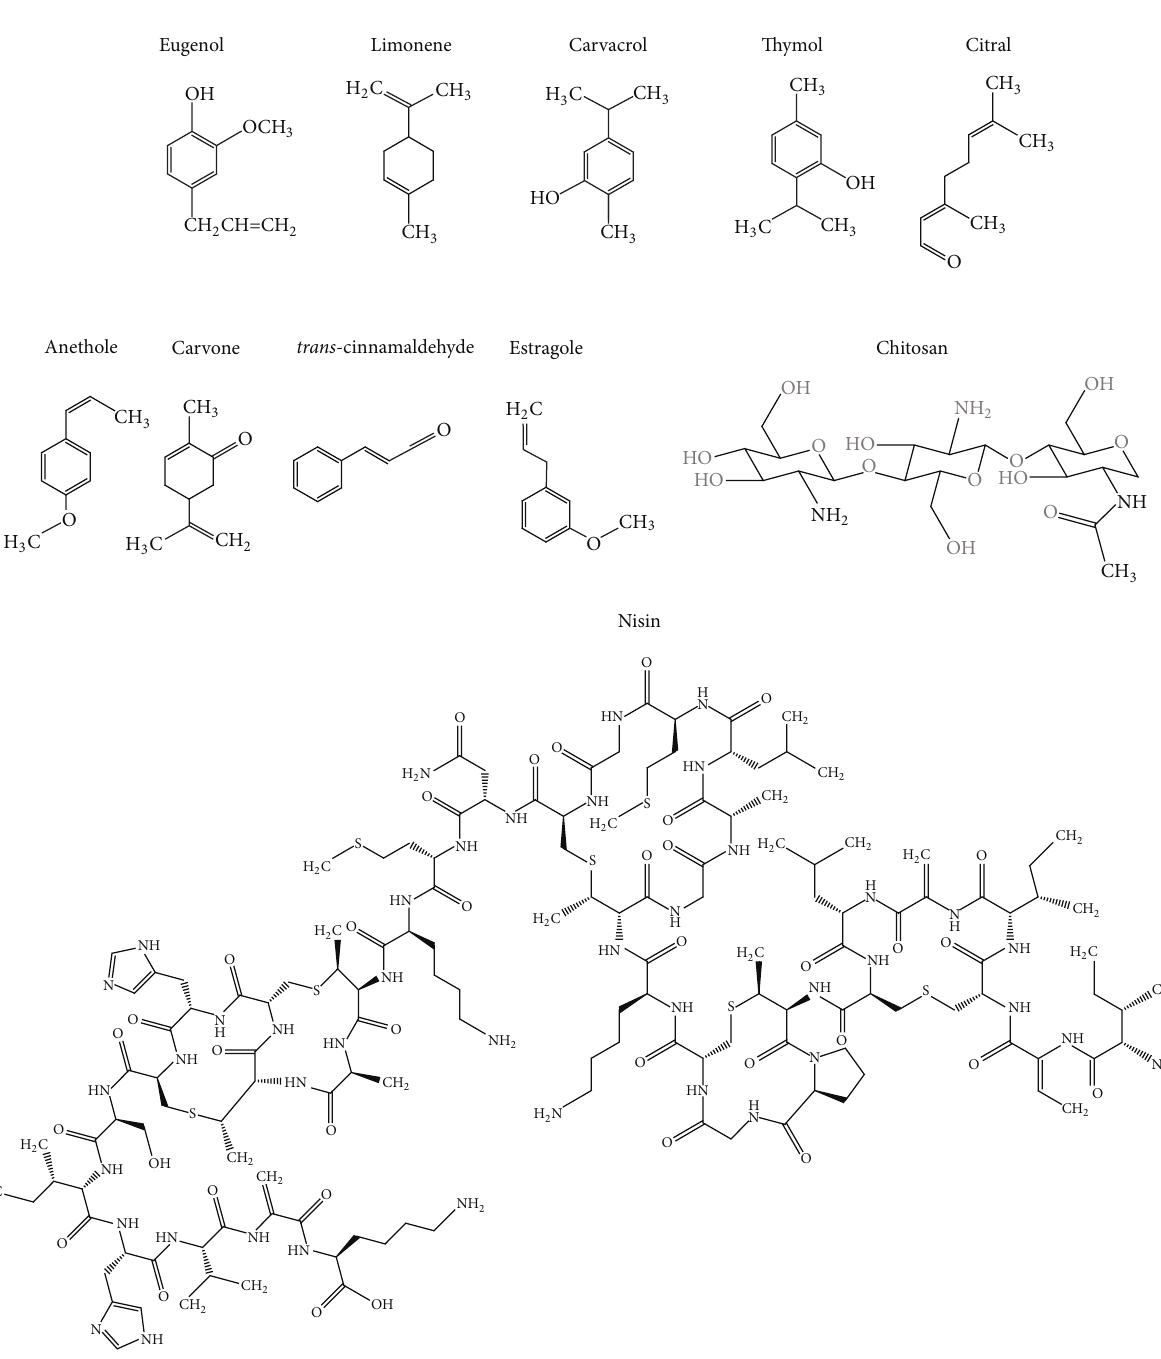
Figure 2: Structures of natural food